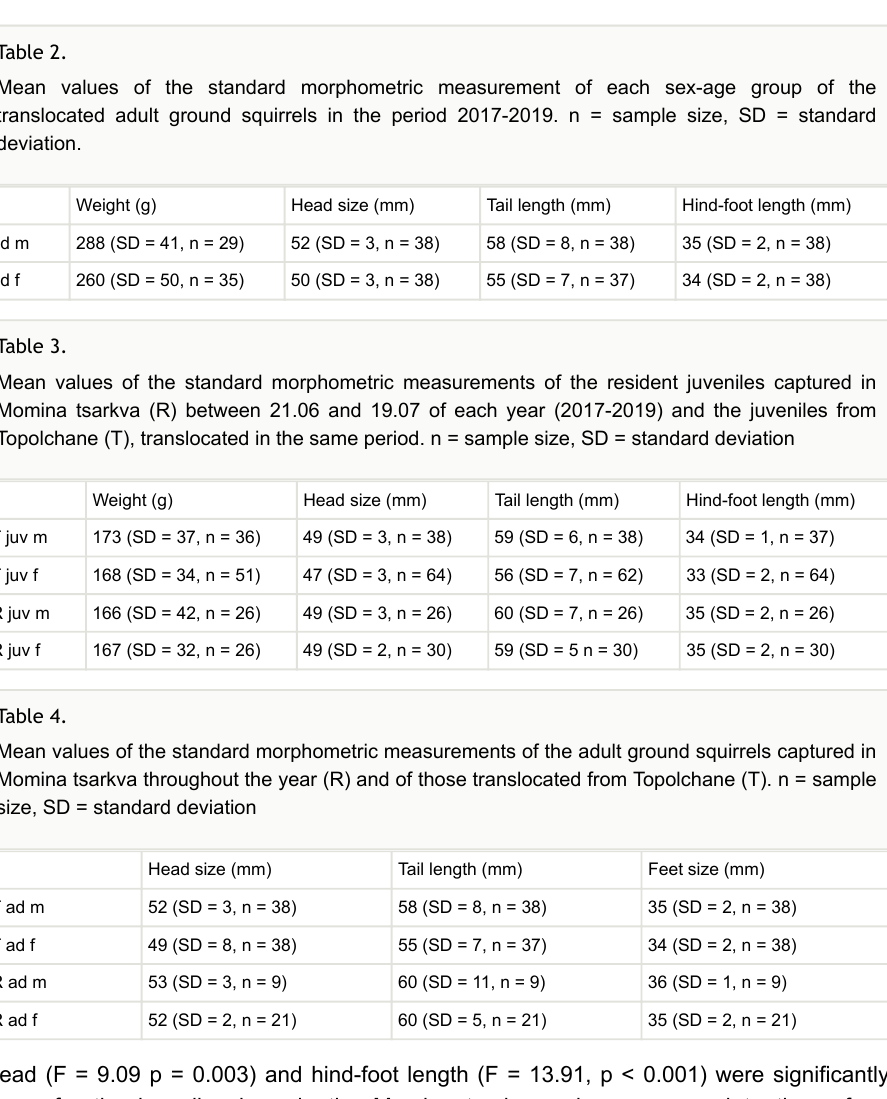
larger for the juveniles born in the Momina tsarkva colony compared to those from Topolchane according to the results of the multivariate analysis when controling for sex (Table 3). The differences in the weight (F = 0.32, p = 0.571) and the tail length (F = 1.38, p = 0.242) were not significant. The hind-foot length were significantly different between the sexes (F = 8.23, p < 0.005), the difference in head size was close to significant (F = 3.73, p = 0.055,) whereas the weight and the tail length were not (weight - F = 0.14, p = 0.710, tail length - F = 2.47, p = 0.118). MANOVA analysis showed that the adult individuals from Topolchane were significantly smaller compared to those from Momina tsarkva, based on all three morphometric elements - head (F = 7.89, p = 0.006); tail (F = 5.11, p = 0.026) and feet (F = 8.19, p =